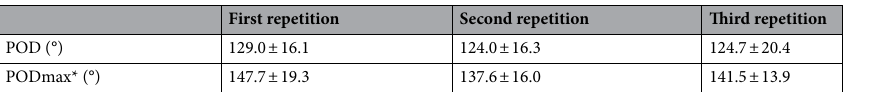
Table 1. Knee angle during jack-knife stretching. Data were represented as mean ± SD. *p < 0.05 (POD vs. PODmax).